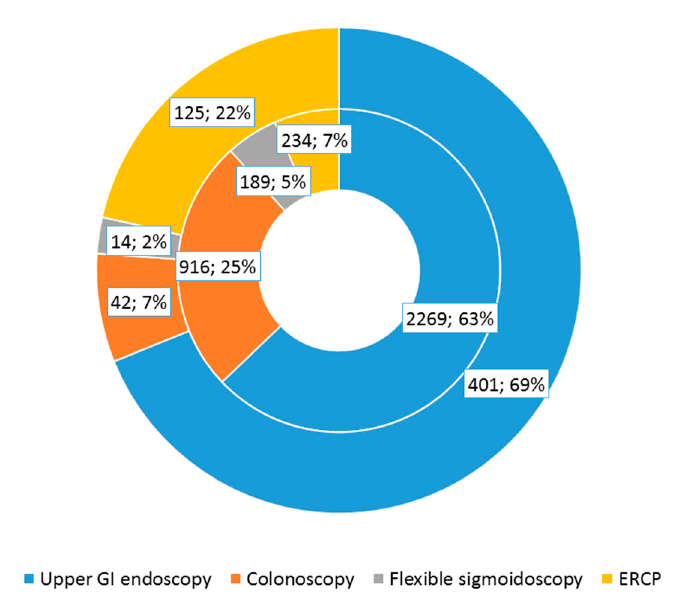
Figure 2. Impact of COVID-19 on the numbers of endoscopic procedures.